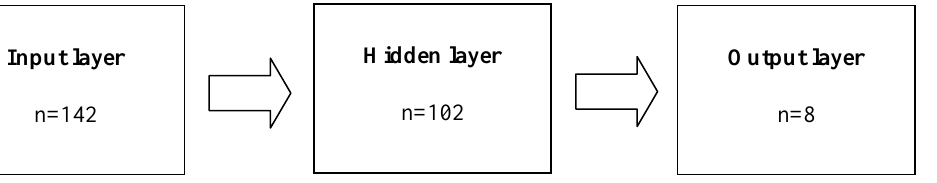
Figure 16. Optimal reduced-size ANN. Table 3. Selected ANN quality assessment and MSE values (bold shows the best result).